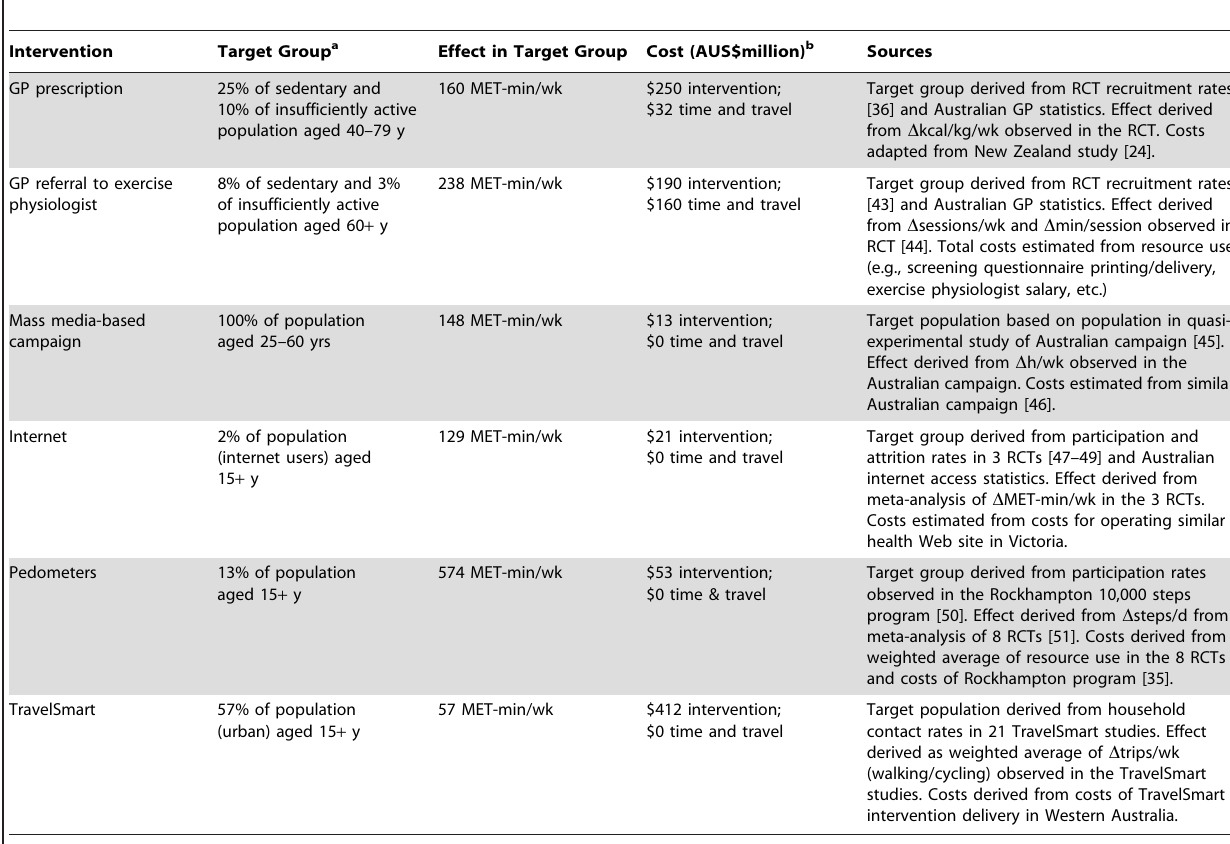
Table 1. The target groups, physical activity effects, and costs associated with implementing the physical activity interventions in Australia for one year (2003 baseline